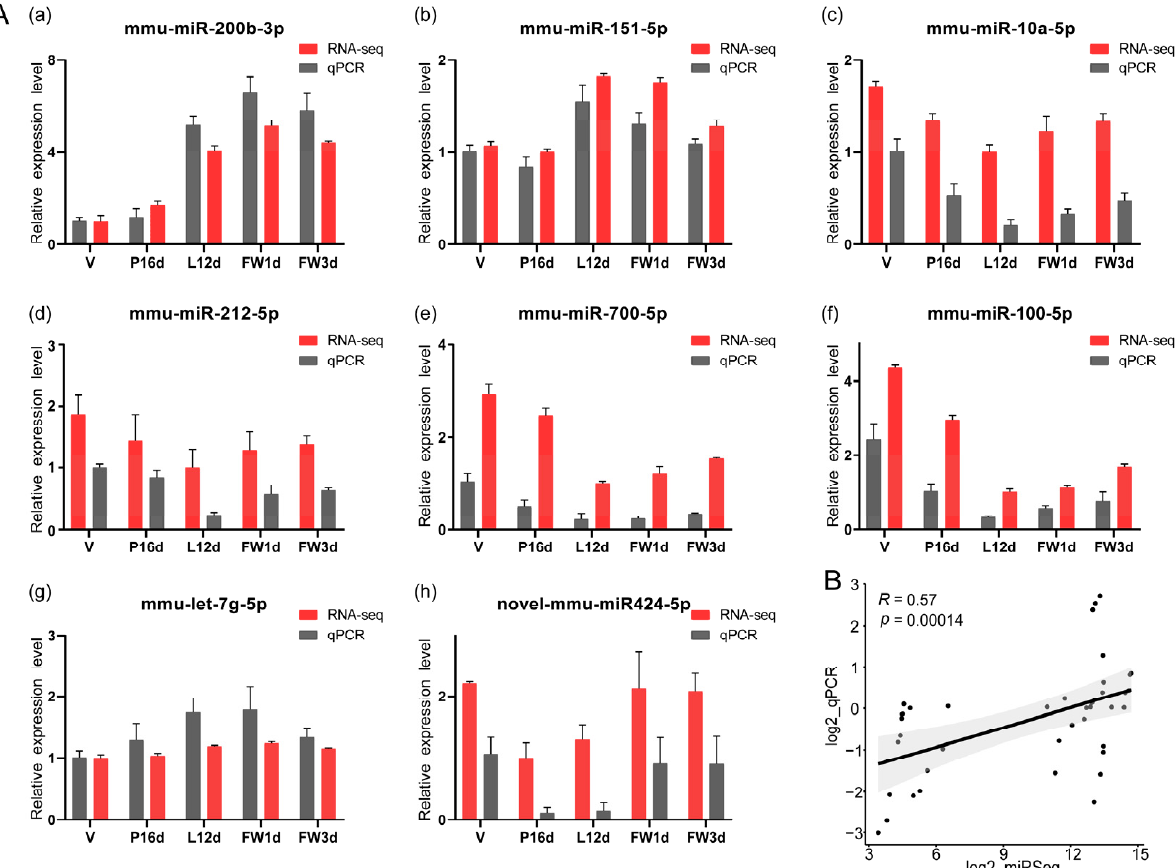
Figure 2. Validation of the expression of miRNAs using qPCR: ( A ) ( a – h ). The relative expression levels of eight selected miRNAs measured by qPCR in five stages. The expression levels were normalized against the expression level of the internal control U6 using the comparative cycle threshold (2 − ∆∆ Ct ) method. Meanwhile, for each miRNA, the stage of lowest sequencing abundance in the five different stages was used as a reference sample for comparisons. Data are presented as the mean ± standard error of the mean (SEM) for three replicates. ( B ) Scatterplot between the qPCR and RNA-Seq results of the eight selected miRNAs. The y-axis corresponds to the log2 of the qPCR ratios, while the x-axis shows the log2 of the RNA-Seq ratios, for the eight selected miRNAs.